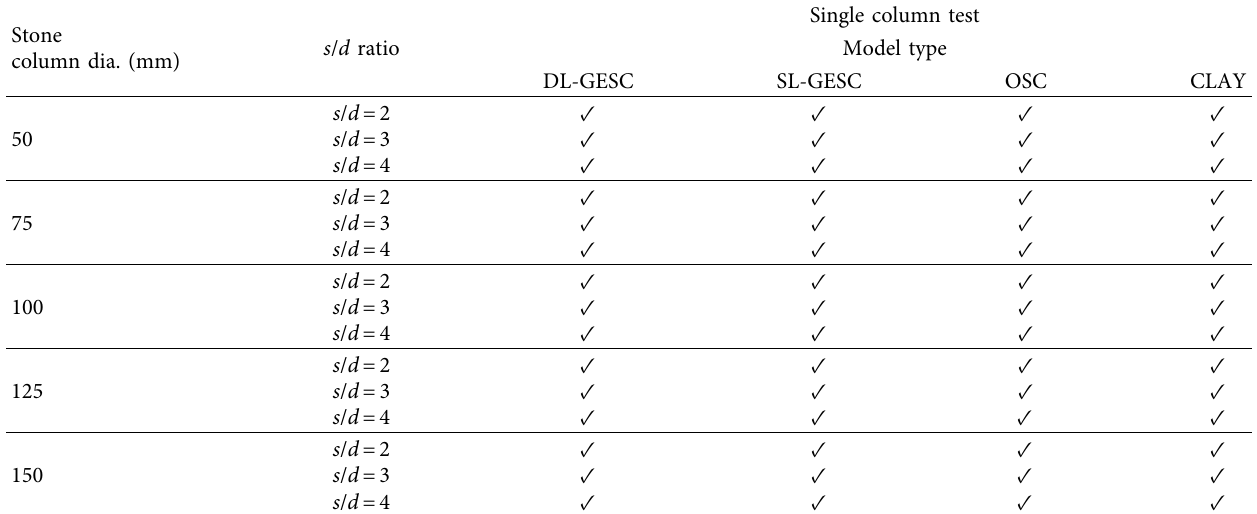
Table 2: An overview of the FEM models generated.